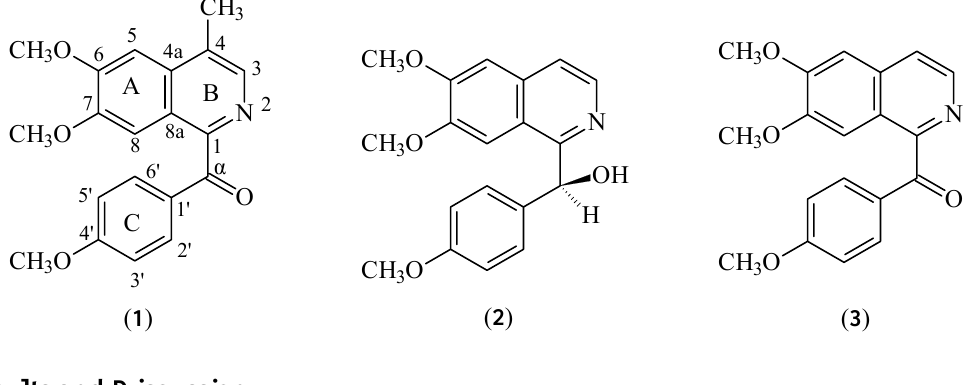
Figure 1. Structure of alkaloids 1–3